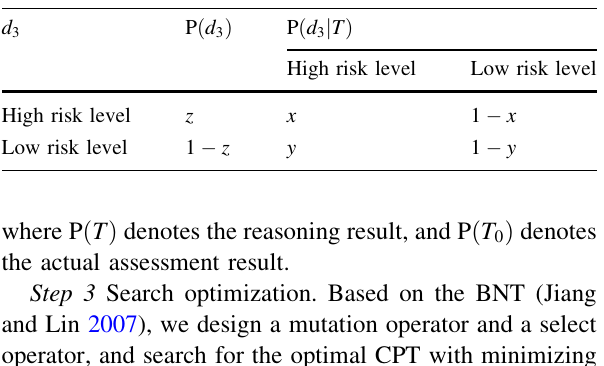
Table 9 Actual probability distribution of sea ice disaster in the Bohai Sea